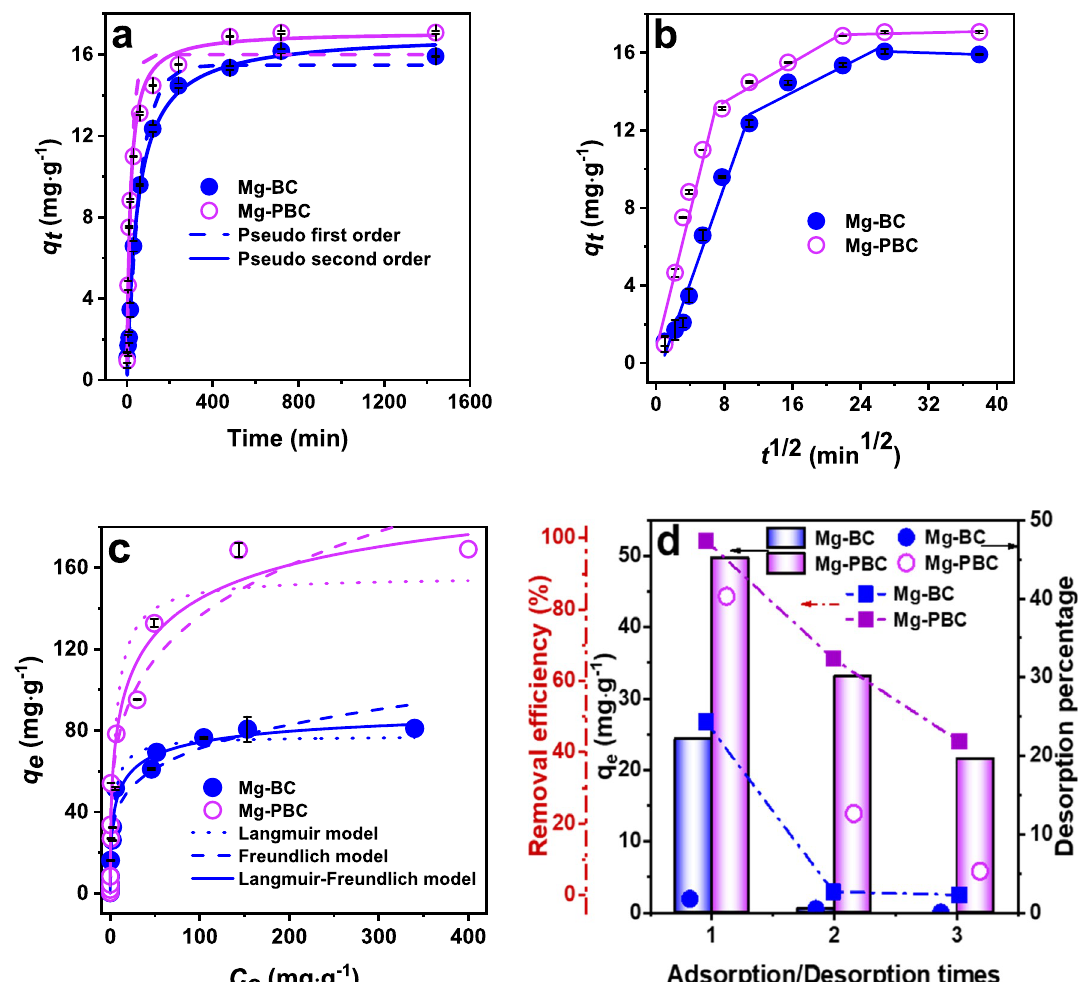
Fig. 4 Kinetic data fitted to pseudo-first and second order model ( a ) and inner particle diffusion model ( b ); P adsorptive recovery isotherm data fitted to the Langmuir, Freundlich, and Langmuir-Freundlich isotherm models ( c ); results of the removal efficacy of P by Mg-BC and Mg-PBC and desorption rate of sorbed P over three sorption-desorption cycles ( d ) ((Reaction condition: 0.05 g absorbent, 25 mL 100 mg•L − 1 P solution; desorption solution: 100 mL 1 mol•L − 1